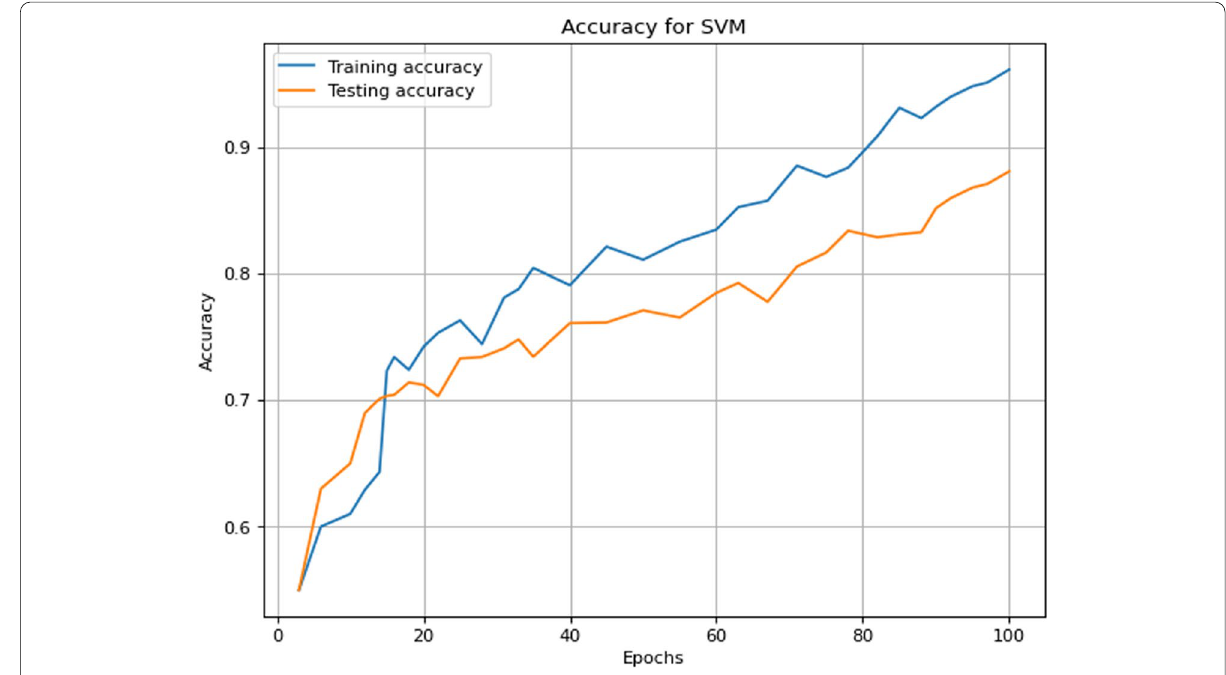
Fig. 22 Accuracy for our proposed model with KNN